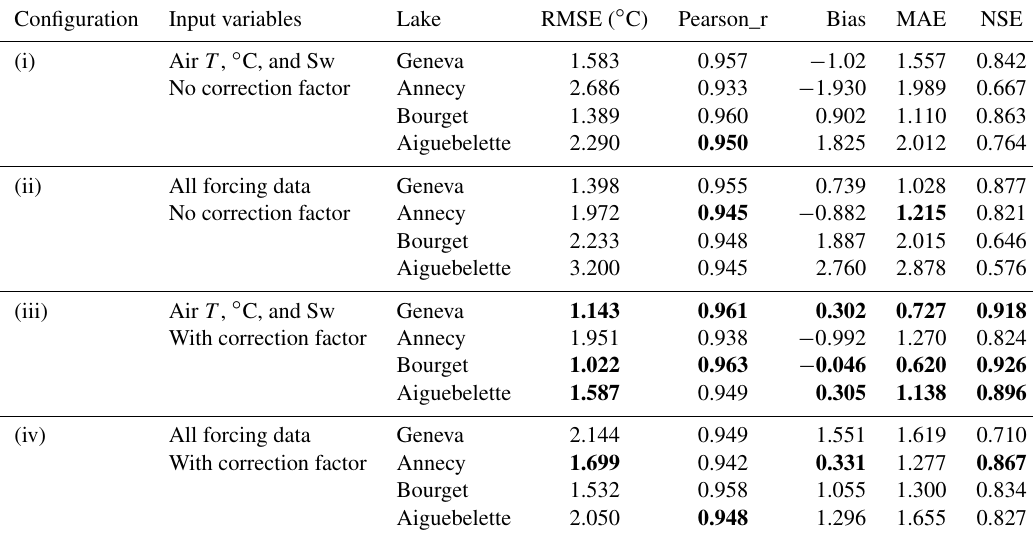
Table 4. Meteorological forcing configuration and performance metrics for MyLake (ISIMIP) calculated between daily simulations and observations. Outputs comparison between four configurations: (i) only air temperature ( T , ◦ C) and shortwave radiation (Sw) extracted from ISIMIP3B without a correction factor, and others from meteorological observations; (ii) all ISIMIP3b forcing data with no correction factor; (iii) only air T , ◦ C, and Sw extracted from ISIMIP3B with a correction factor; (iv) all ISIMIP3b forcing data with a correction factor applied to air T , ◦ C, and Sw, over 10 years. Bold: best performance metrics for each lake within the four configurations (Lower RMSE, bias and MAE; Higher Pearson r and NSE).